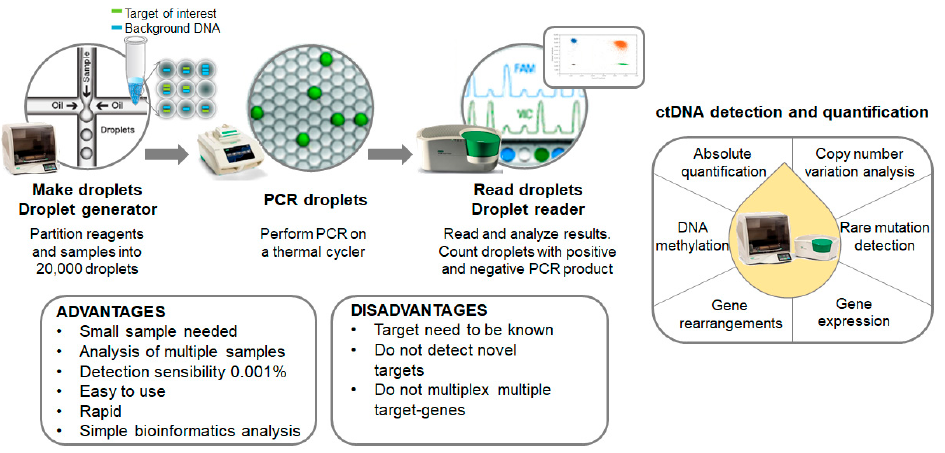
Figure 2. Overview of the mutation screening process. Summary of both advantages and disadvantages of the technology disclosed and other putative applications.